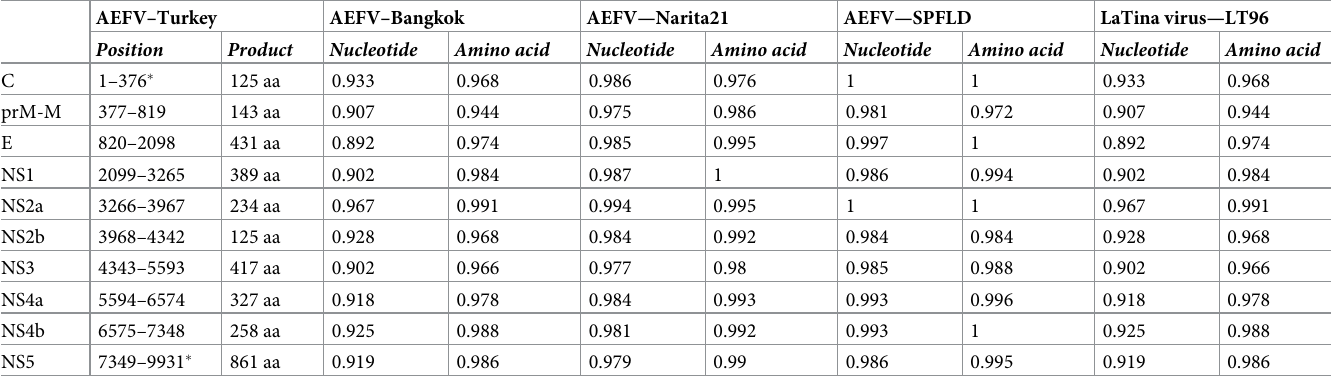
Table 3. Functional organization of the AEFV-Turkey genome and comparison with related viruses. Similarity rates are given in percent.